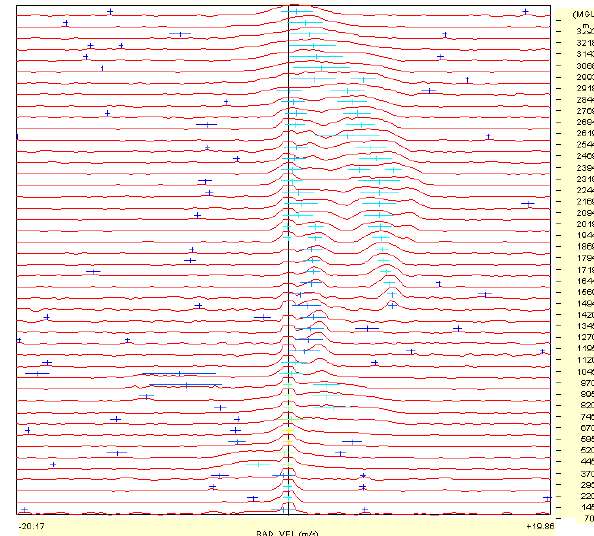
Fig. 4d. Stacked as a function of height of Doppler spectra from the vertical beam corresponding to the 45 gate of the low mode for 06:23UTC. The height of the gate above the ground level is indi- cated on the y-axis, The Doppler velocity on x-axis. Each spectrum is plotted using a logarithmic scale for the power. Positive velocity is for motion towards the wind